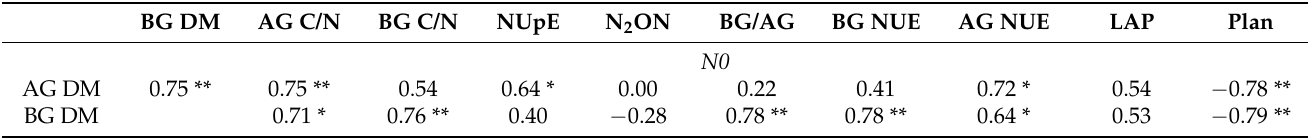
Table 3. Spearman’s correlation α coefficients showing the relationships between the N 2 ON emission, biomass variables and microbial